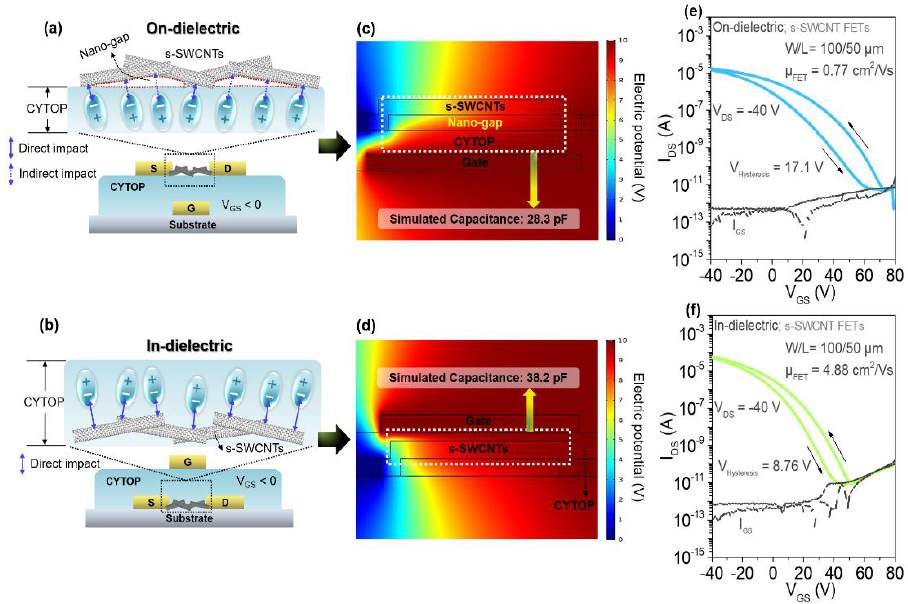
Figure 3. Schematics of SWCNT FETs with CYTOP ( a ) on-dielectric and ( b ) in-dielectric configuration. Corresponding charge accumulation data obtained from the FEA simulation of ( c ) on-dielectric and ( d ) in-dielectric configuration. The transfer characteristics of the SWCNT FETs with ( e ) on-dielectric and ( f ) in-dielectric configuration (W/L = 1000/50 μm, V DS = −40 V).